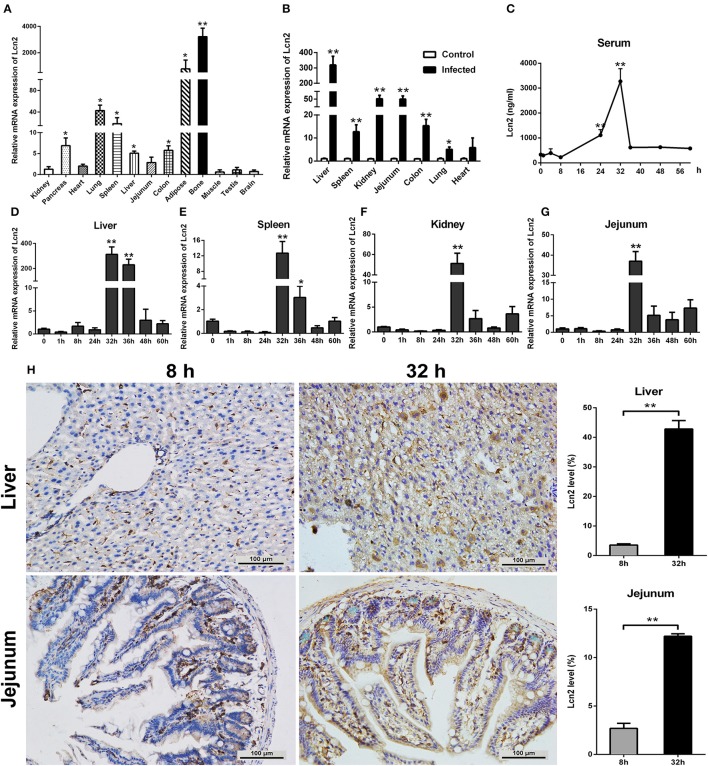
Elevated lipocalin 2 (Lcn2) during E. coli O157:H7 infection. (A) Real-time PCR analysis of the levels of Lcn2 mRNA expression in indicated tissues of mice. (B) The mRNA levels of Lcn2 expression in indicated tissues of control and E. coli O157:H7-infected mice. (C) Serum levels of Lcn2 protein concentration in E. coli O157:H7-infected mice after challenge at different time points. (D–G) The mRNA expression levels of Lcn2 in indicated tissues from E. coli O157:H7-infected mice after challenge at different time points. (H) Protein levels of Lcn2 in mice detected on immunohistochemistry sections of liver and jejunum at 8 and 32 h after challenge with E. coli O157:H7. Original magnification was 200×. Values are average means of triplicate experiments. Error bars depict SEM (n = 4 per time point). Results are expressed as means ± SEM. *P < 0.05, and **P < 0.01.